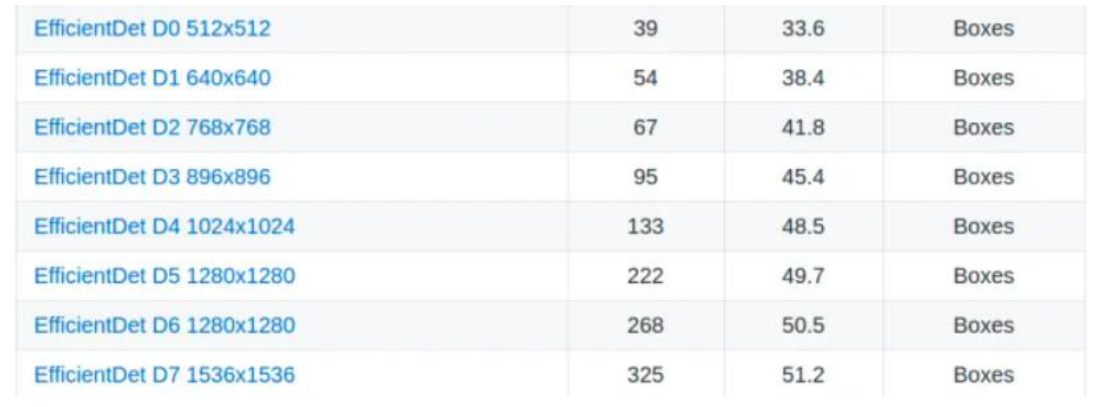
Figure 17. SSD floating mine detection.